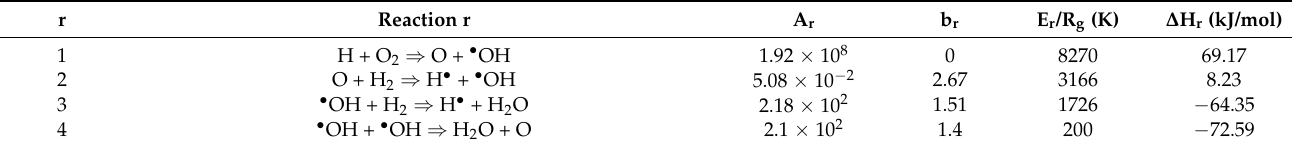
Figure 1. Schematic illustration of the iterative algorithm used to characterize the equilibrium size distribution within a population of acoustic cavitation bubbles. Table 1. Adopted scheme of the possible reactions occurring inside an O 2 /H 2 O collapsing bubble [13]. M is the third body. A is expressed in (m 3 /mol · s) for two body reaction (m 6 /mol 2 · s) for a three-body